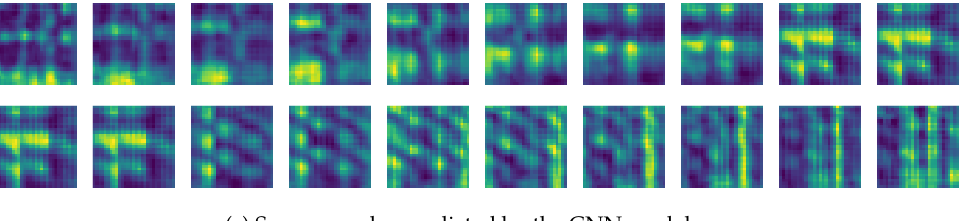
( b ) The target cross recurrence plot to be predicted from the FNO model (a) and CNN model (c).